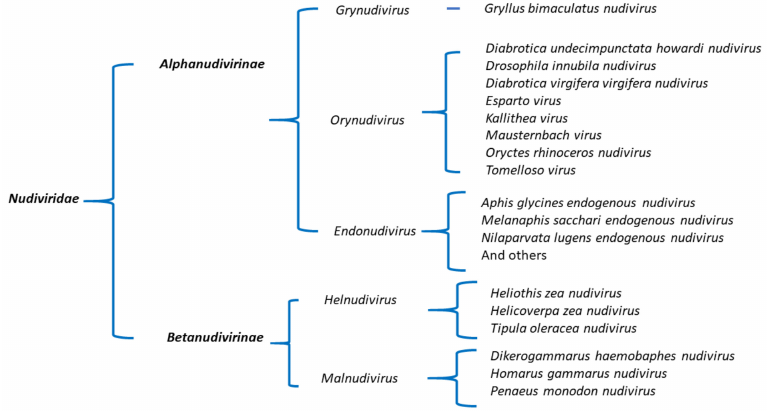
Figure 6. Proposed new taxonomic classification of Nudiviridae. Two subfamilies and five genera are